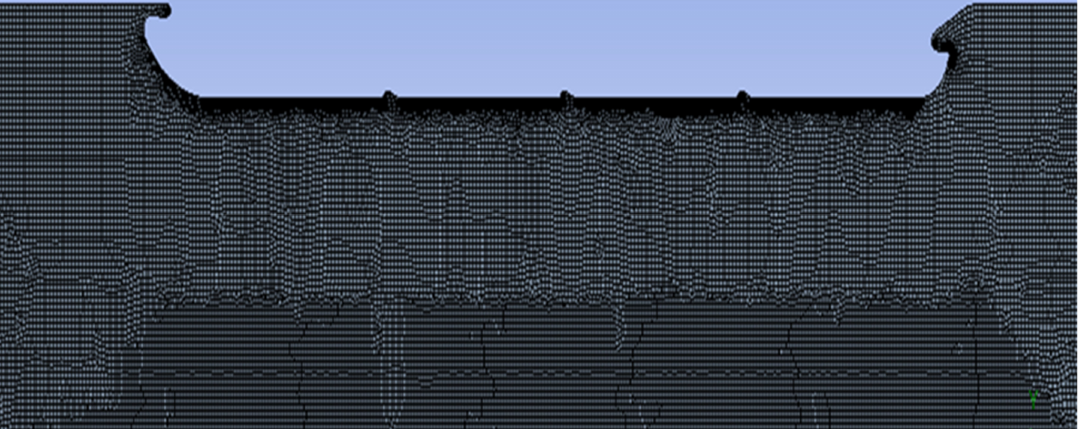
Figure 2. Meshed air lubrication